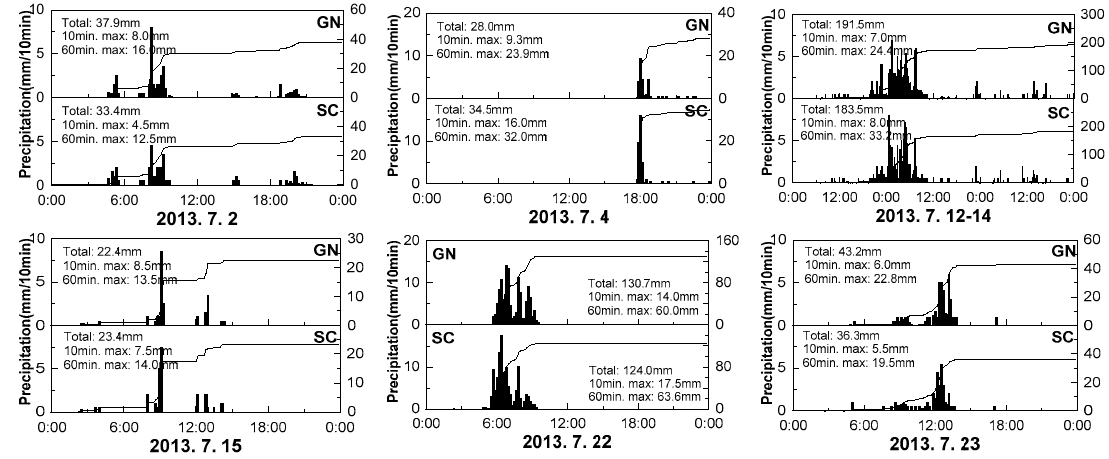
Figure 5. Time series rainfall information for all of the rainfall events.